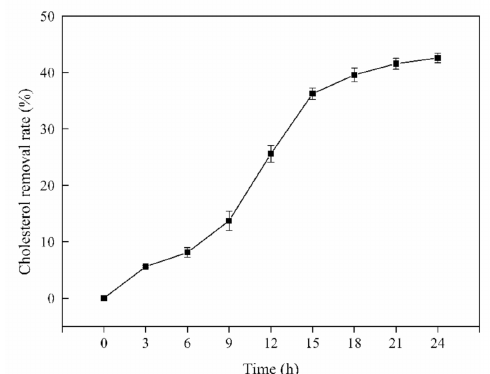
Figure 1. Cholesterol-lowing ability of L. rhamnosus JL1 in vitro. Error bars indicate standard deviation ( ±